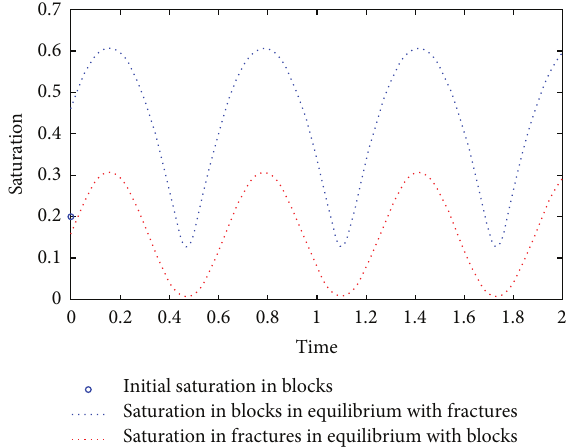
Figure 5: Saturation in blocks and fractures in the case of the total equilibrium between them.